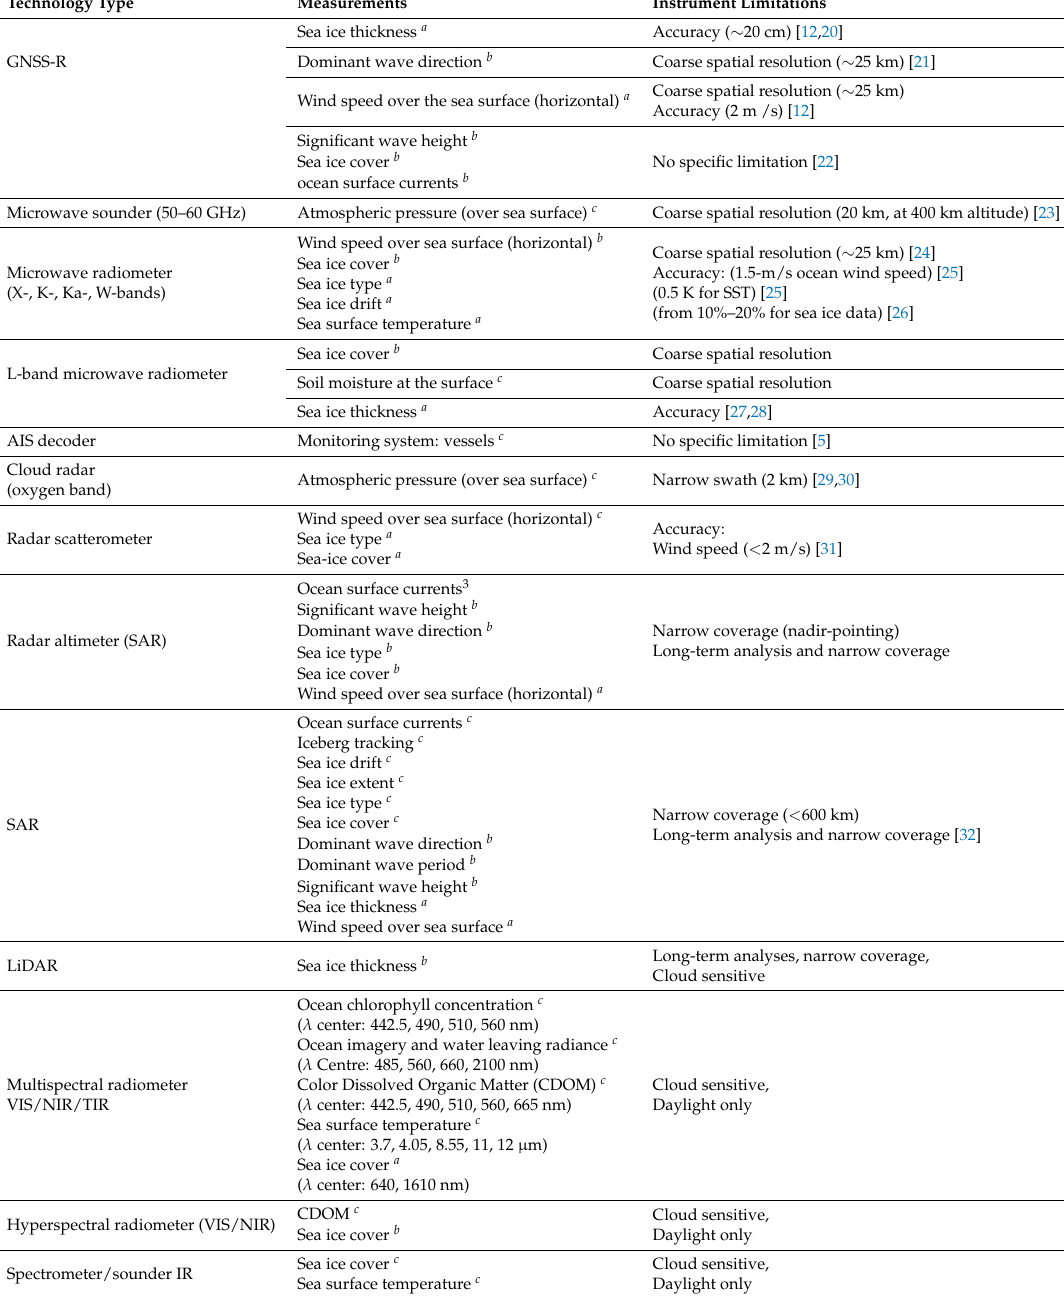
Table 3. Mapping of the potential technologies to cover measurements with gaps. The technology limitations from the perspective of the measurement requirements are